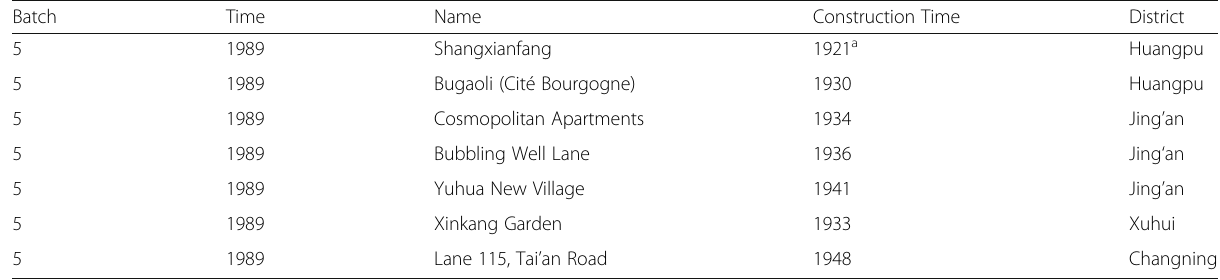
Table 1 The seven residential areas or buildings were all listed in 1989. Among these nominations, Shangxianfang has the longest history of existing, Bugaoli follows close